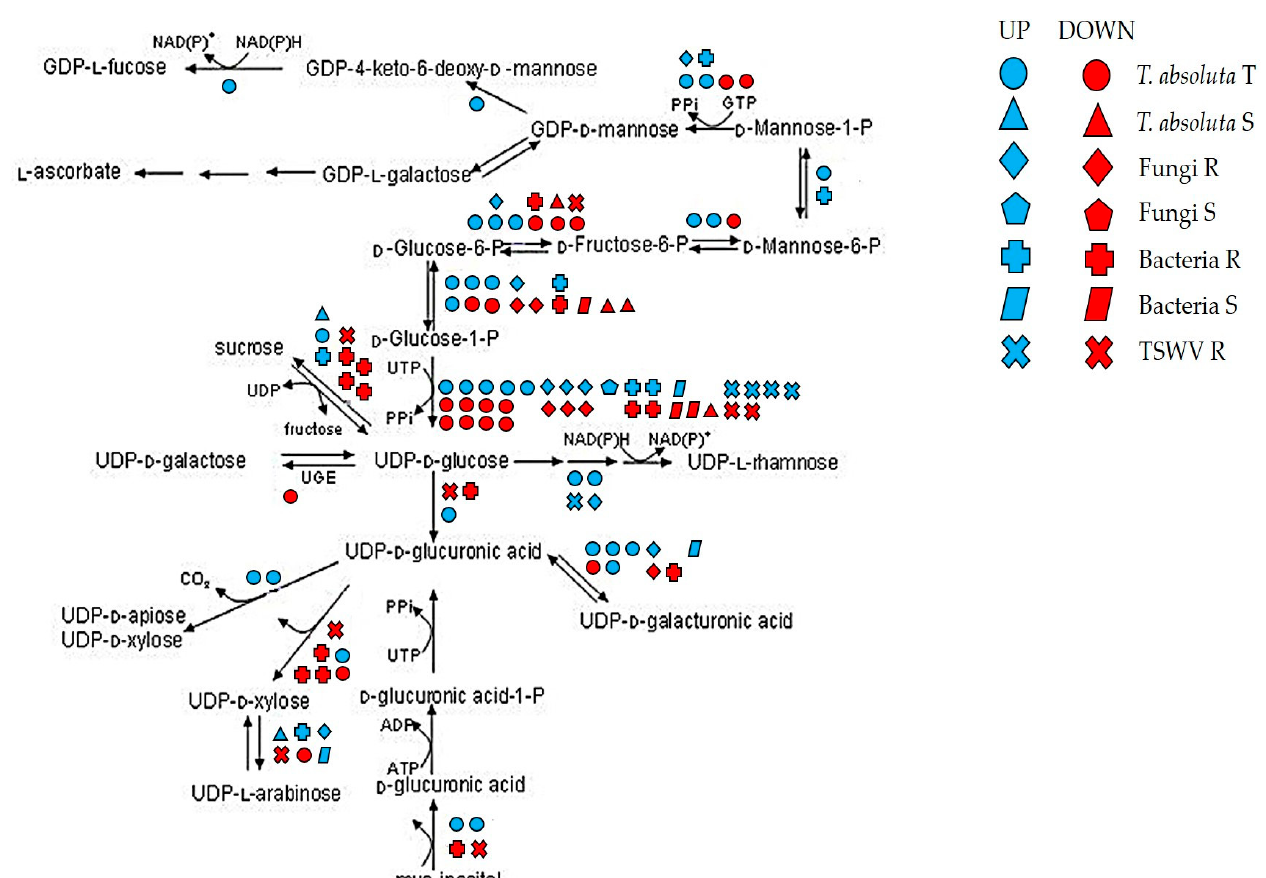
Figure 4. DEGs under various biotic stress involved in the biosynthesis of cell wall precursors. Blue: upregulated; red: downregulated. R = resistant; S = susceptible; T = tolerant genotype. Cellulose is one of the main components of the cell wall. In this study, two FLAs (Solyc01g091530 and Solyc10g005960) were downregulated among R genotypes to fungi,